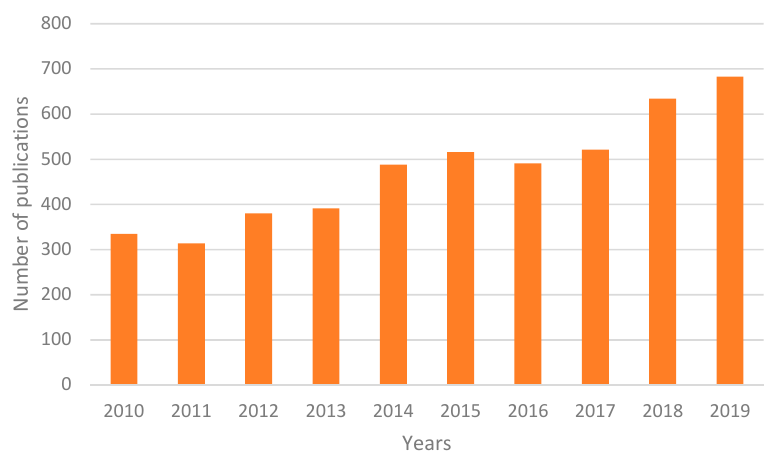
Figure 6. Number of published articles containing "conceptual framework" in the title indexed in Scopus. Source: Scopus (2020).